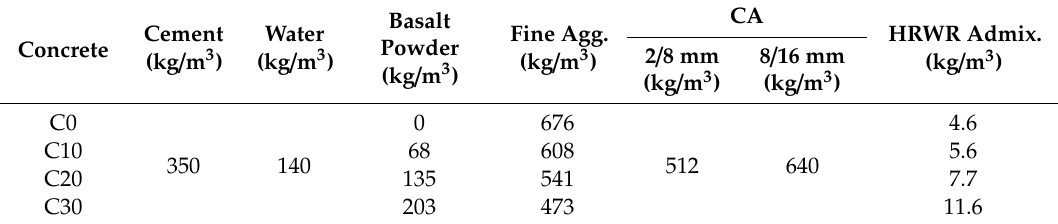
Table 3. Concrete mixture proportions. C10, C20, and C30: concretes with di ff erent amount of basalt powder replacing 10%, 20%, and 30% of the sand by mass, CA: coarse aggregate, HRWR: high-range